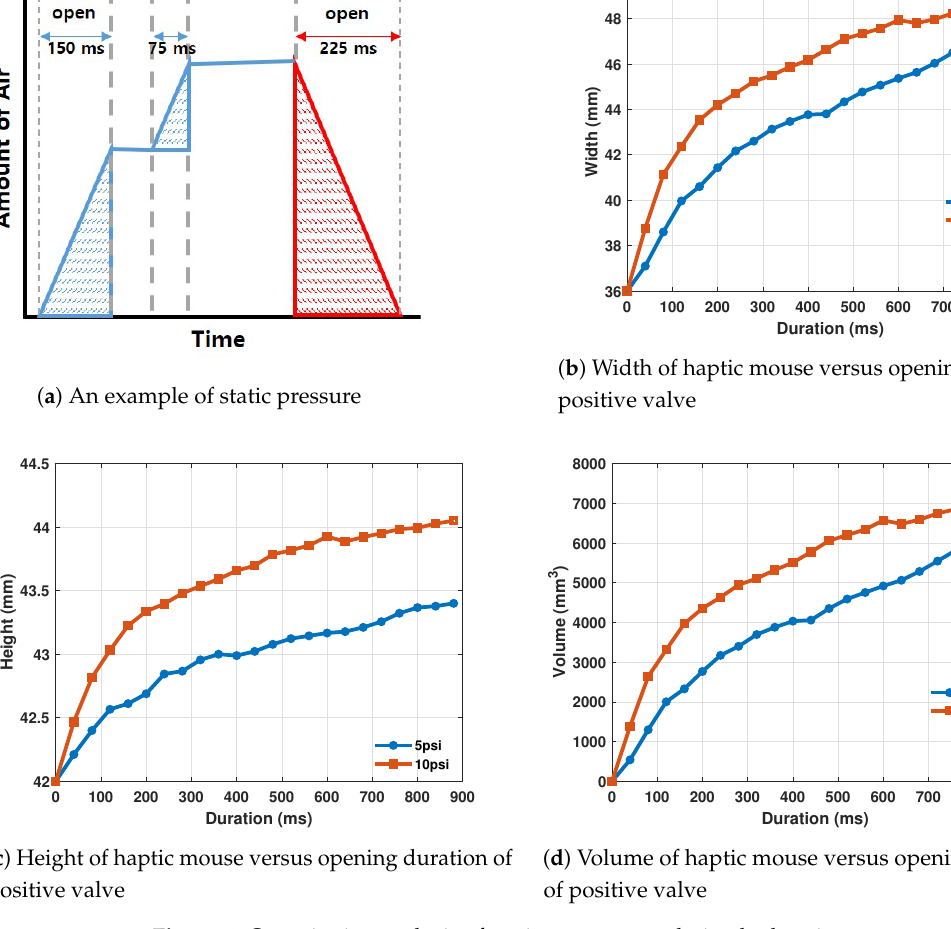
Figure 4. Quantitative analysis of static pressure rendering by haptic